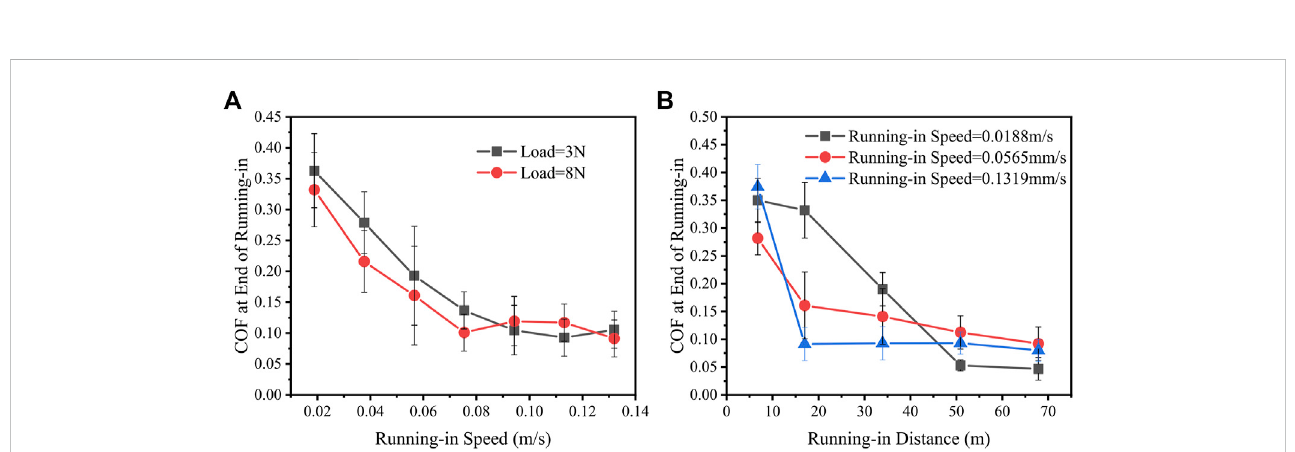
FIGURE 3 (A) Intherunning-inprocess,thecoef fi cientoffriction(COF)attheendofrunning-ininH 2 SO 4 underloadsof3 Nand8 Ndecreasedwiththeincreasein therunning-inspeed. Therunning-indistancewas16.96m; (B) coef fi cientoffrictionattheendofrunning-inunderaloadof8 Ndecreasedwiththeincrease in the running-in distance. The running-in speeds were 0.0188 m/s, 0.0565 m/s, and 0.1319